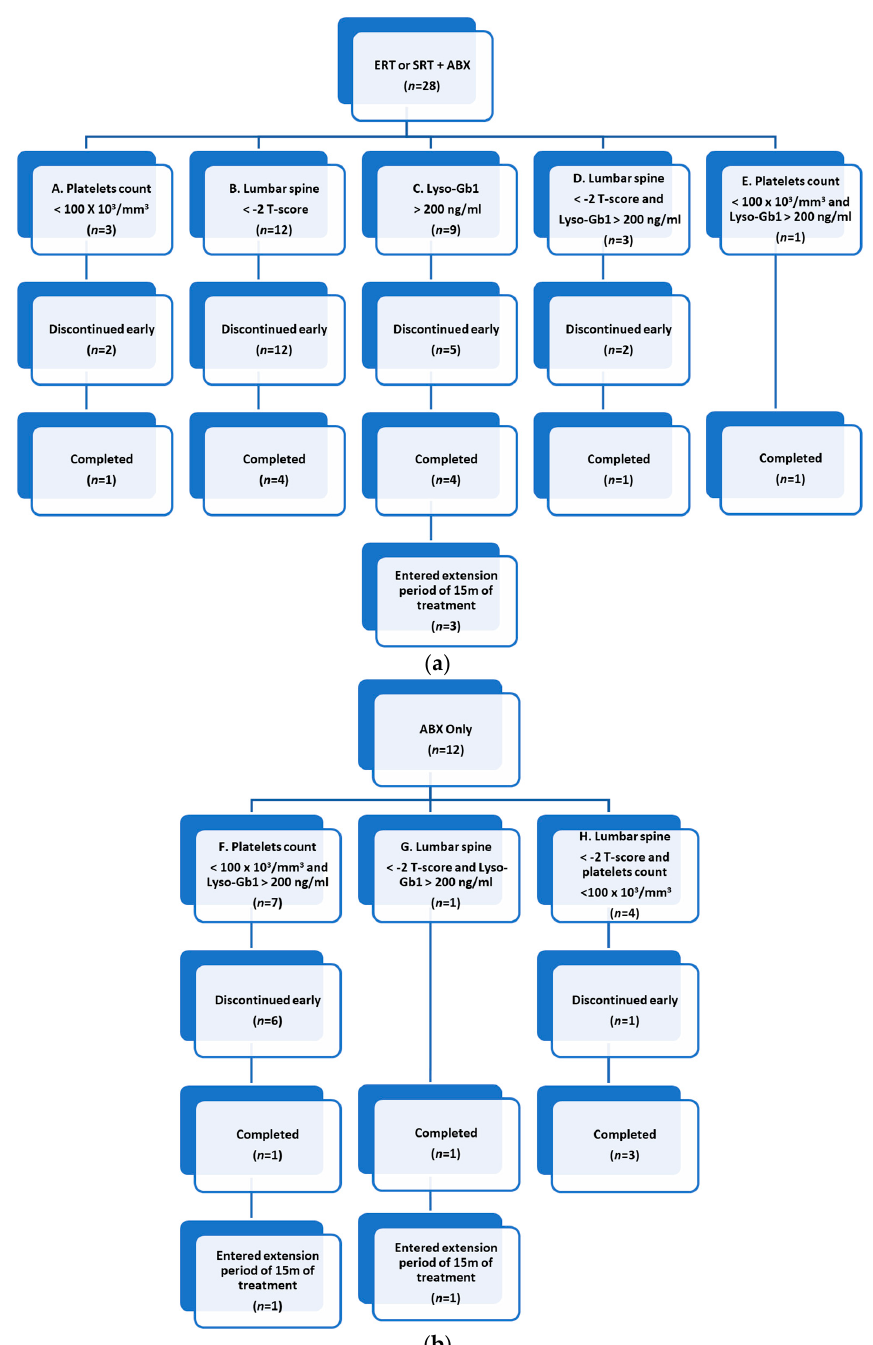
Figure 1. Enrolment groups, dropouts, and study completion of ( a ) patients with suboptimal/poor response to ERT or SRT and ( b ) patients naïve to ERT or SRT, i.e., never received ( n = 2) or have been o ff therapy for at least 12 months ( n = 10). The group categories are outlined from A to H.